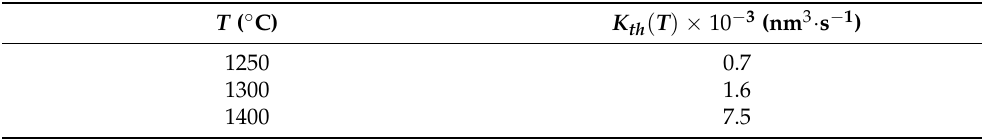
Table 4. Rate coefficient K th ( T ) for p = 3 at various